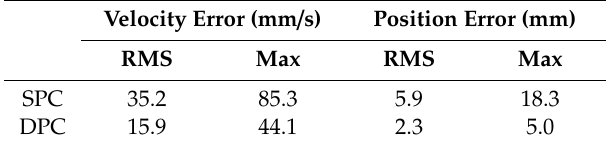
Table 6. Comparisons of position tracking and velocity fluctuation between the SPC and